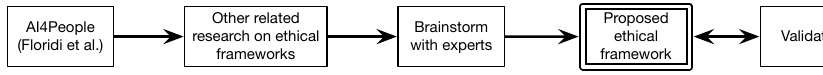
Figure 1. Research